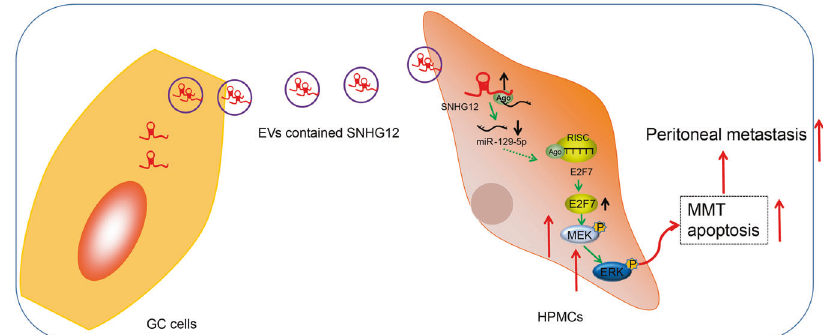
Fig. 7 The molecular mechanism of gastric cancer (GC) cell-derived extracellular vesicles (EVs) in peritoneal metastasis of GC. Note: gastric cancer cell-derived extracellular vesicles elevate E2F7 expression and activate the MAPK/ERK signaling to promote peritoneal metastasis through the delivery of SNHG12. SNHG12 lncRNA small nucleolar RNA host gene 12, miR-129-5p microRNA-129-5p, E2F E2F transcription factor 7, MAPK mitogen-activated protein kinase, ERK extracellular regulated protein